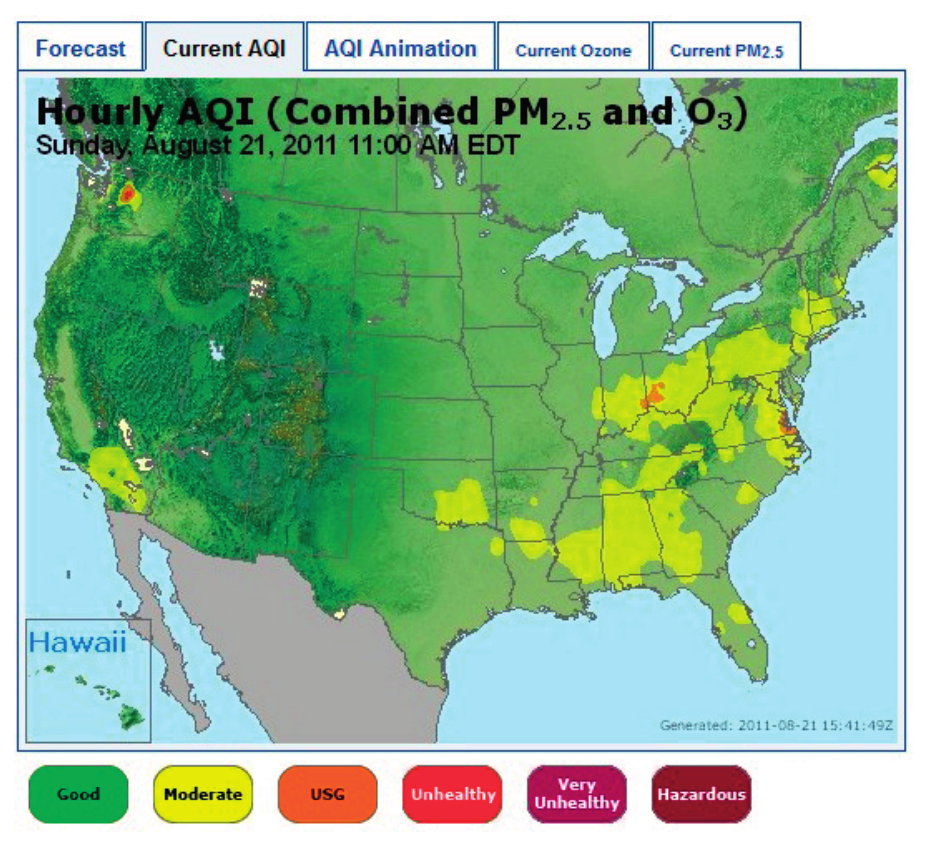
Figure 1. A U.S. national PM 2.5 -O 3 combined AQI map (Source: AIRNow